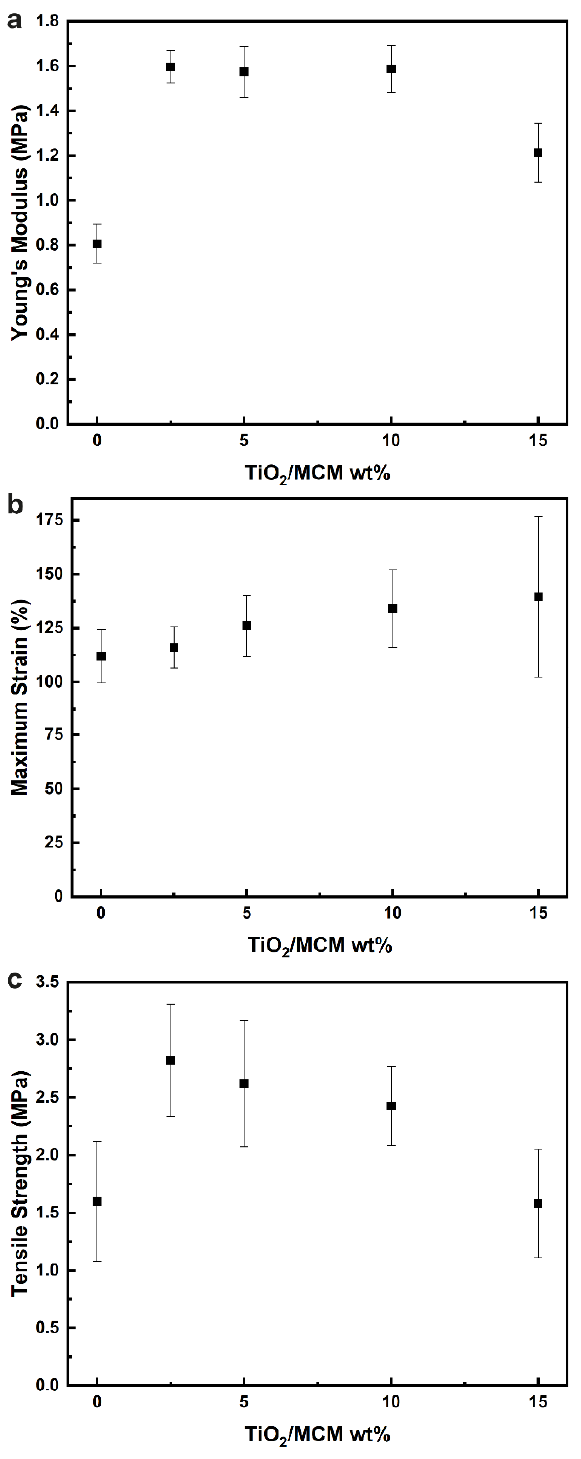
Figure 4. The elastic modulus ( a ), maximum strain ( b ), and tensile strength ( c ) of TiO 2 /MCM/PDMS composites at various TiO 2 /MCM wt%.